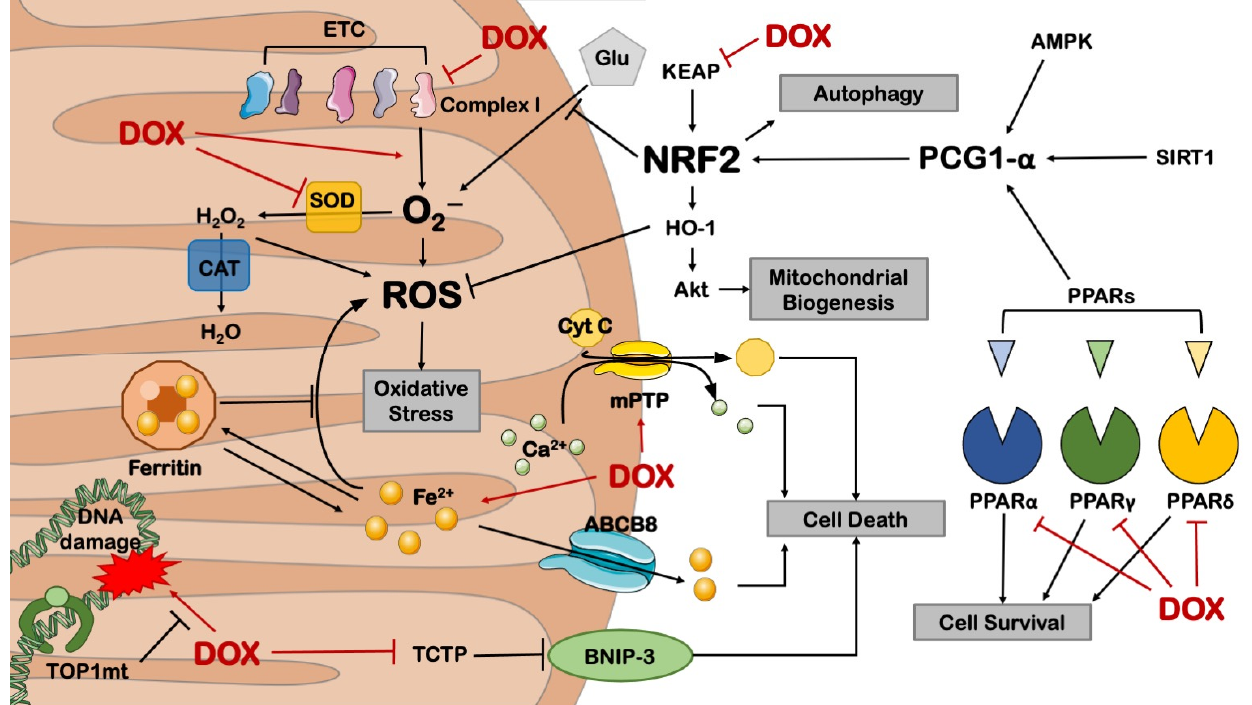
Figure 2. Mitochondrial derangements in DOX-induced cardiotoxicity. ABCB8 = ATP-binding cassette sub-family B member 8; AMPK = AMP-activated protein kinase; BNIP-3 = BCL2 19 kD protein-interacting protein 3; CAT = catalase; Cyt C = cytochrome C; ETC = electron transport chain; Glu = glucose; HO-1 = heme oxygenase 1; KEAP = Kelch-like ECH-associated protein; mPTP = mitochondrial permeability transition pore; NRF2 = nuclear respiratory factor 2; PGC-1 α = PPAR γ coactivator 1 alpha; PPAR = peroxisome proliferator-activated receptor; ROS = reactive oxygen species; SIRT1 = sirtuin 1; TCTP = translationally controlled tumor protein; TOP1mt = mitochondrial topoisomerase 1. This illustration includes elements from Servier Medical Art.